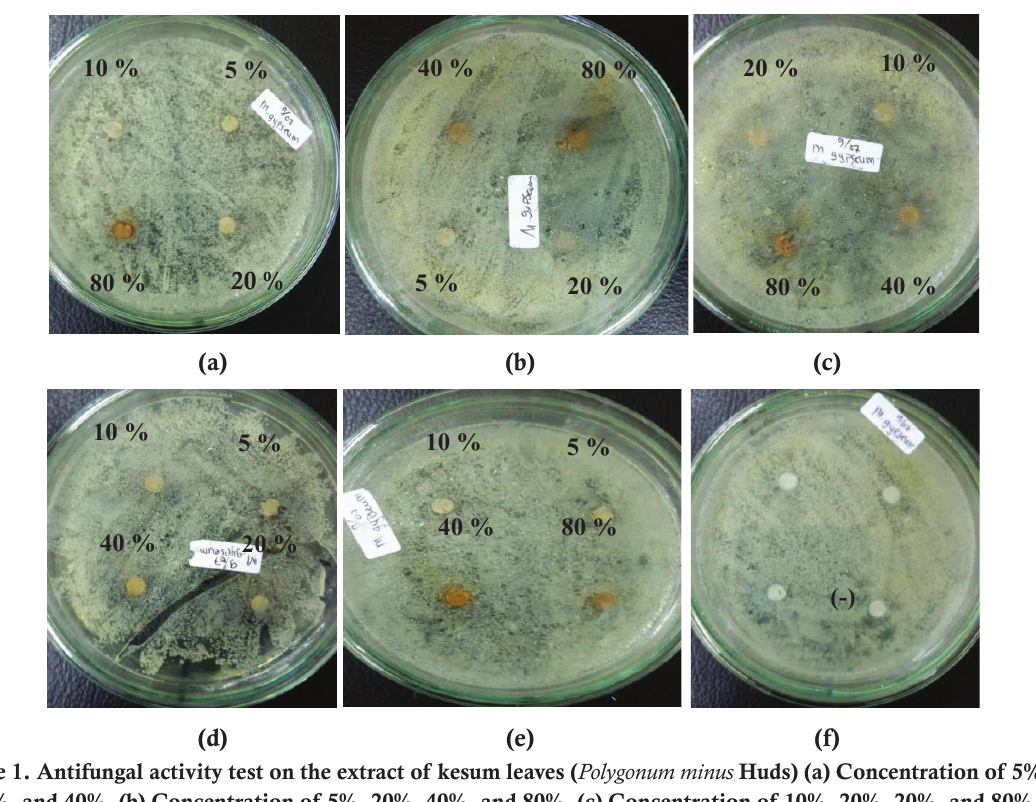
Figure 1. Antifungal activity test on the extract of kesum leaves ( Polygonum minus Huds) (a) Concentration of 5%, 10%, 20%, and 40%. (b) Concentration of 5%, 20%, 40%, and 80%. (c) Concentration of 10%, 20%, 20%, and 80%. (d) Concentration of 5%, 10%, 20%, and 40%. (e) Concentration of 5%, 10%, 40%, and 80%, (f) Negative Control